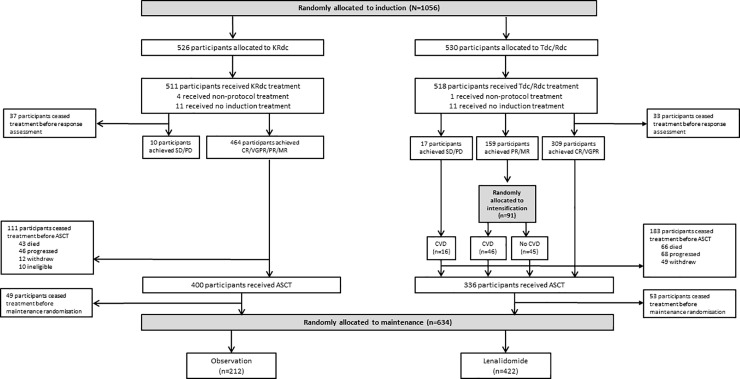
Patient disposition.ASCT, autologous stem cell transplantation; CR, complete response; CVD, cyclophosphamide, bortezomib, and dexamethasone; KRdc, carfilzomib, lenalidomide, dexamethasone, and cyclophosphamide; MR, minimal response; PD, progressive disease; PR, partial response; Rdc, lenalidomide, dexamethasone, and cyclophosphamide; SD, stable disease; Tdc, thalidomide, dexamethasone, and cyclophosphamide; VGPR, very good partial response.